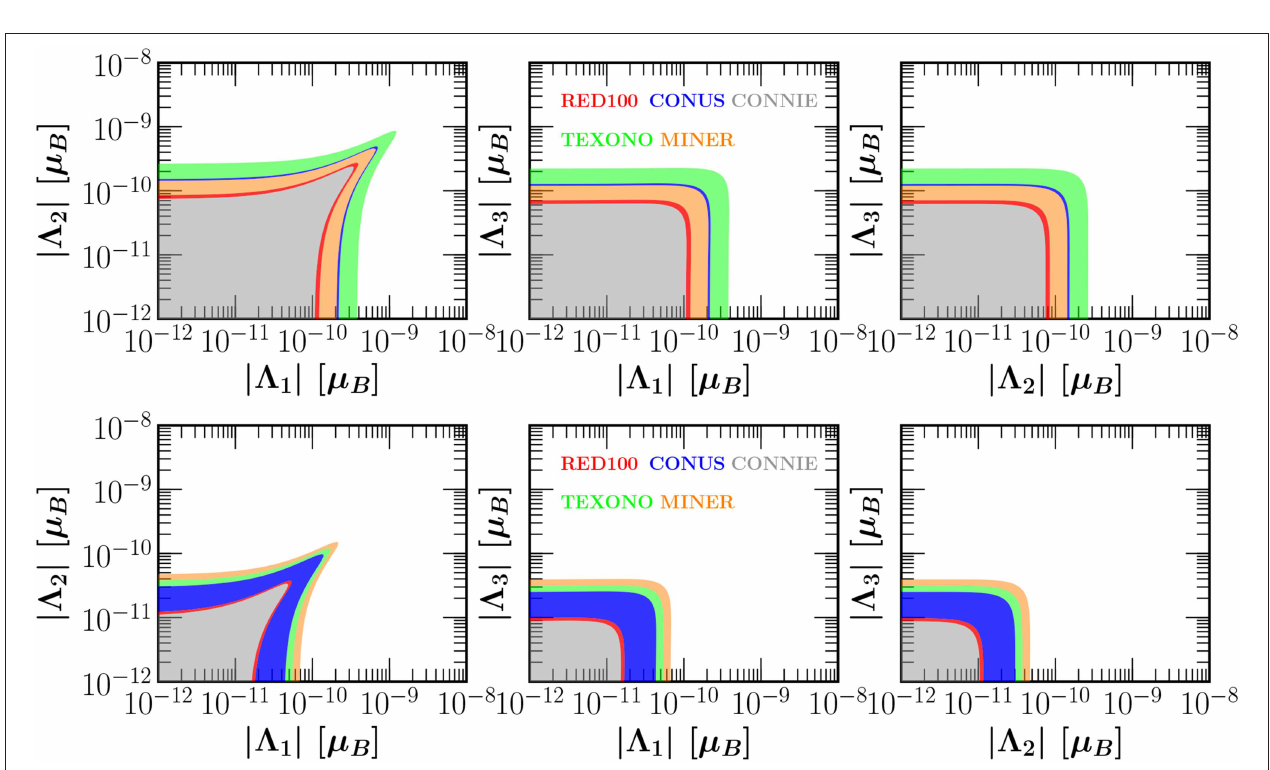
FIGURE 13 | Constraints on electromagnetic neutrino properties by the COHERENT experiment. (Left) Sensitivity to the effective neutrino magnetic moment µ ν (Right) Sensitivity to the neutrino charge-radius International license.